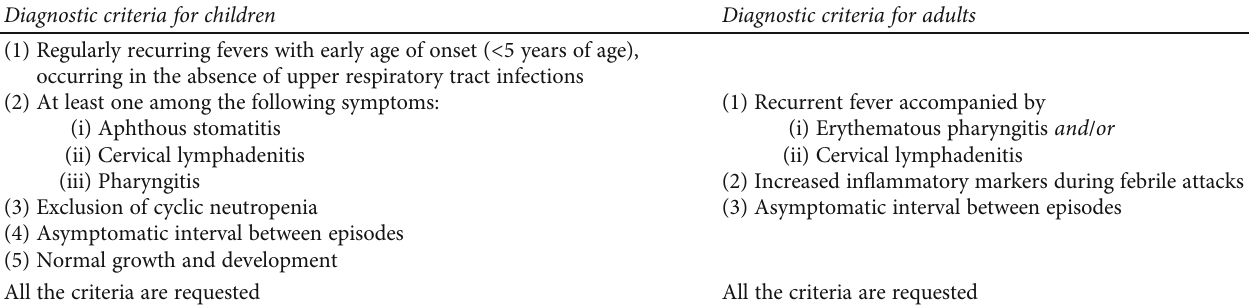
Table 5: Clinical criteria for the diagnosis of periodic fever, aphthous stomatitis, pharyngitis, and cervical adenitis (PFAPA) syndrome in children and adults; adapted from Thomas et al. [145] and Cantarini et al. [146], respectively. Infections, malignancies, autoimmune and other autoin fl ammatory diseases should be ruled out before the application of criteria in adult patients.